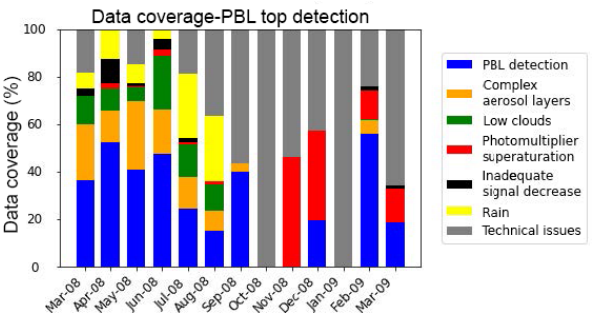
Figure 2. Data coverage of lidar measurements calculated with re- spect to total convective hours (from 4h after sunrise to 1h before sunset) during the measurement days of the